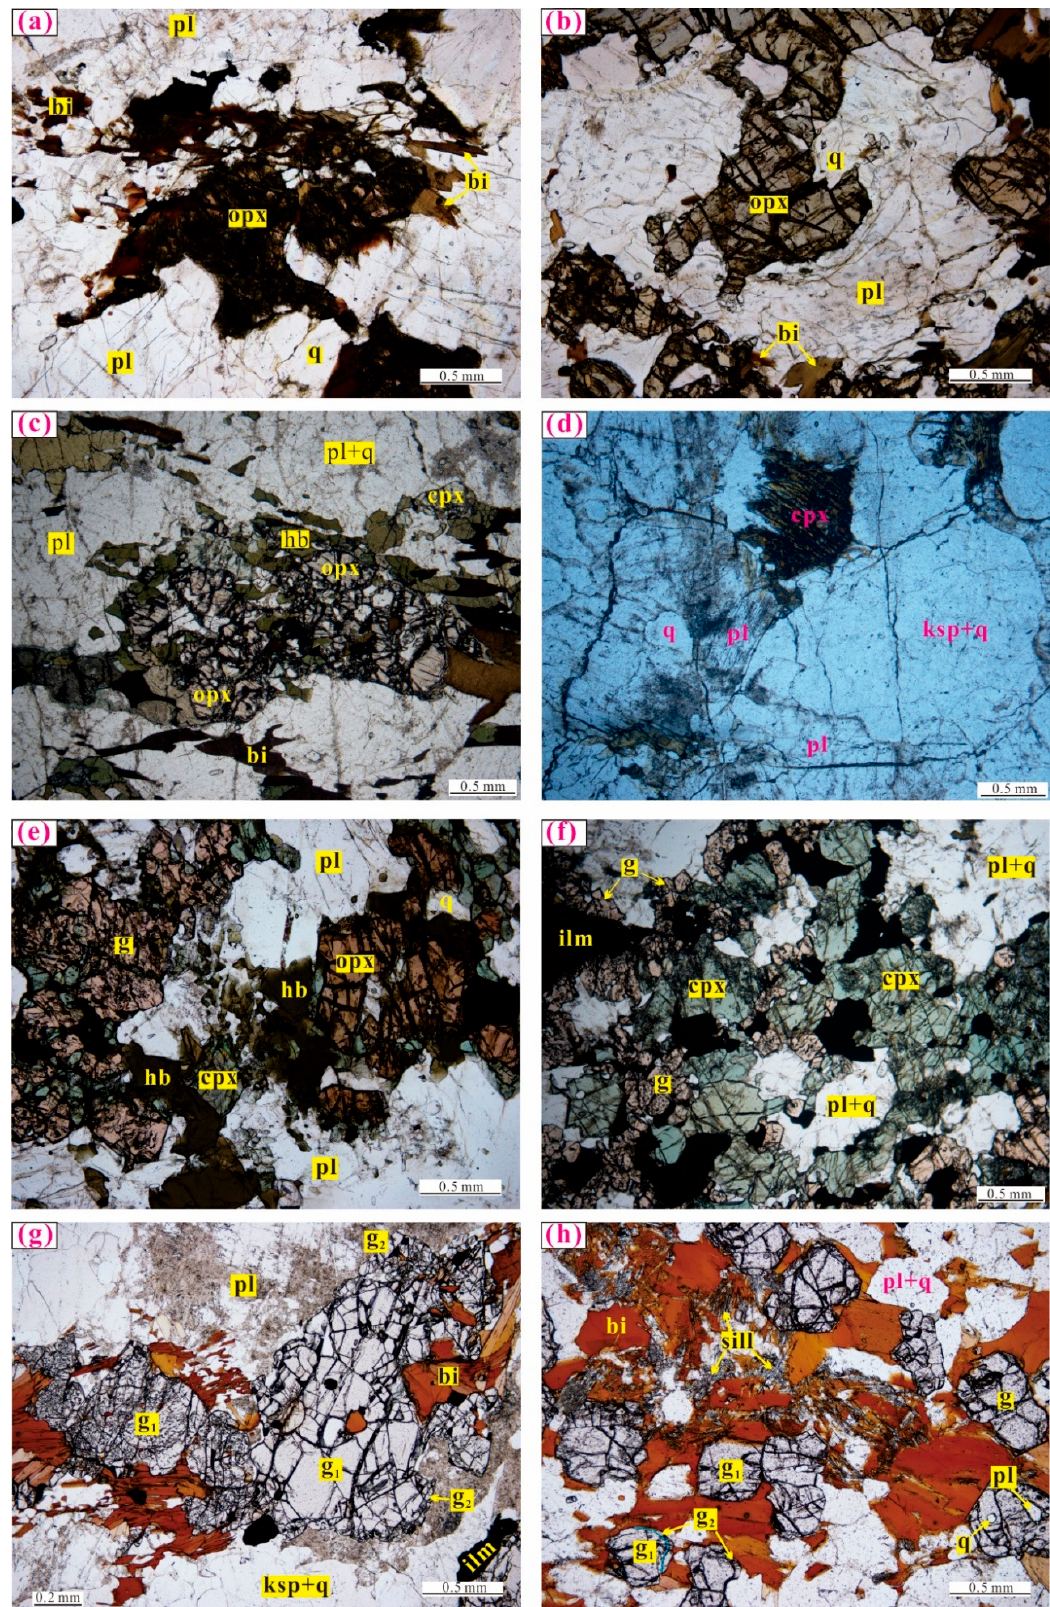
( d ) granodioritic gneiss; ( e ) mafic granulite and leucosome generated during granulite facies metamorphism; ( f ) pelitic granulite with felsic vein formed by partial melting.